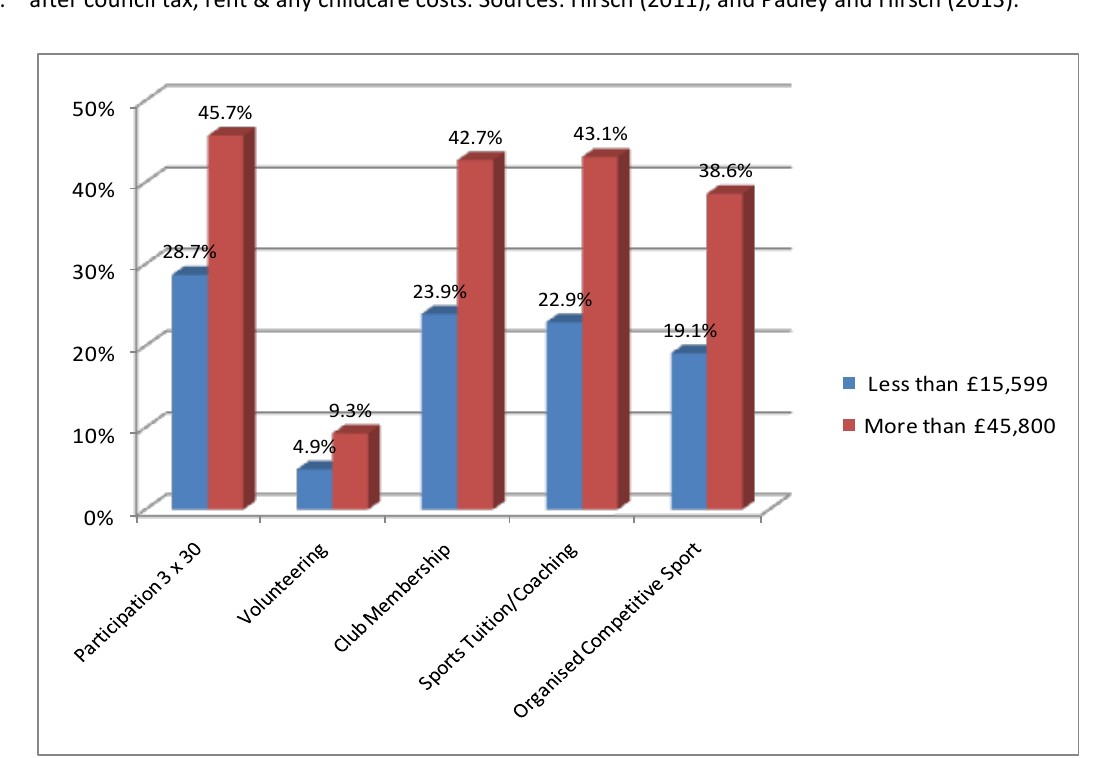
Figure 1. Features of sports participation by 16−25s by income, 2008−2009 (source: Sport England,